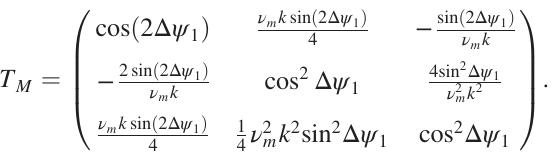
FIG. 11. Longitudinal emittance contribution of a laser modu- lator under various laser strength (left) and undulator period numbers (right). In the left part, modulator period number is fixed at 50, λ u ¼ 5 cm. Negative a 0 means a zero synchrotron phase, and a 0 > 0 for ϕ s ¼ π . In the right part, a 0 is tuned at 4 × 10 − 4 . ρ m is the peak bending radius of the laser